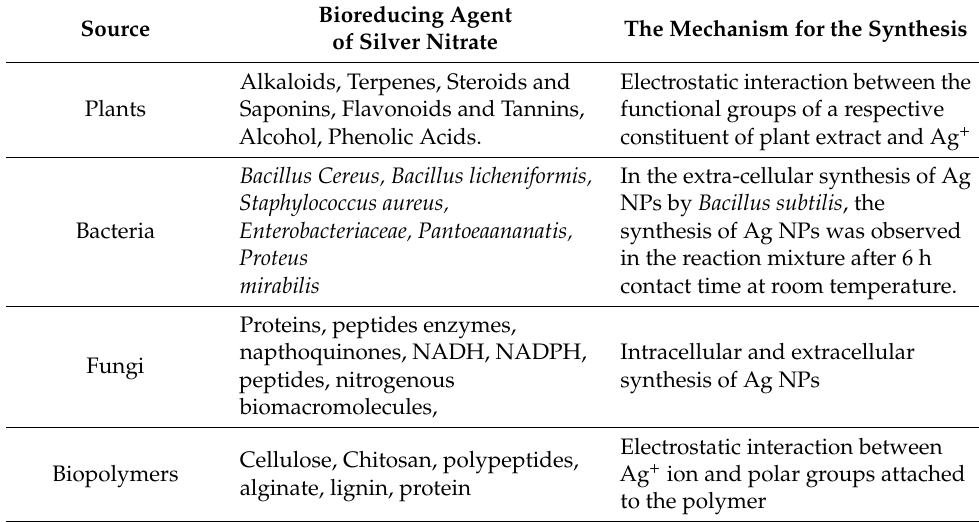
Table 2. Various plant extracts, bacteria, fungi, and biopolymers as bioreducing agents for the synthesis of Ag